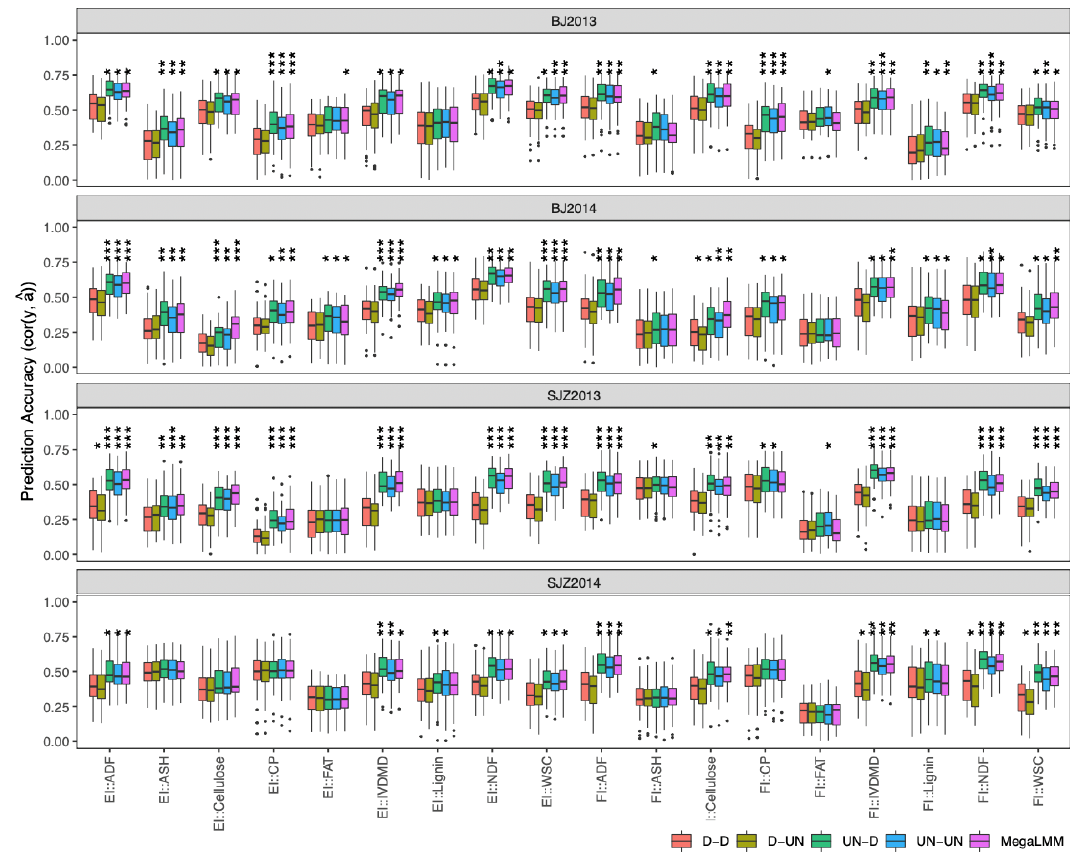
Figure 4. Distribution of prediction accuracies of the 18 stalk quality traits in the DH population across 20 resampling runs estimated by multi-trait models. For each model, the uppercase letters before and after the hyphen represent genetic and residual covariance structures: D = diagonal and UN = unstructured. The corrected resampled t -test was applied to test difference in prediction accuracy between the diagonal (D-D) and other multi-trait model, and significance levels are indicated above each box, with *** significant at p < 0.001, ** significant at p < 0.01, and * significant at p <